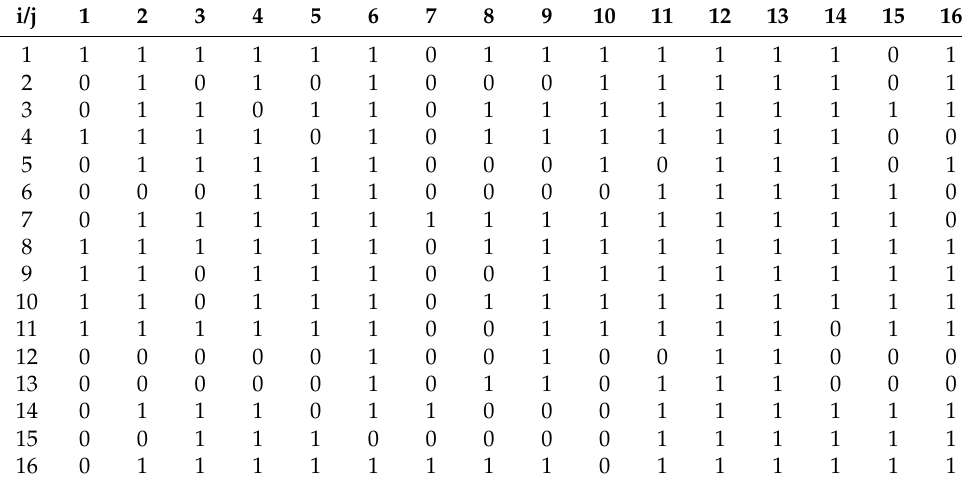
Table 4. Initial Reachability Matrix.